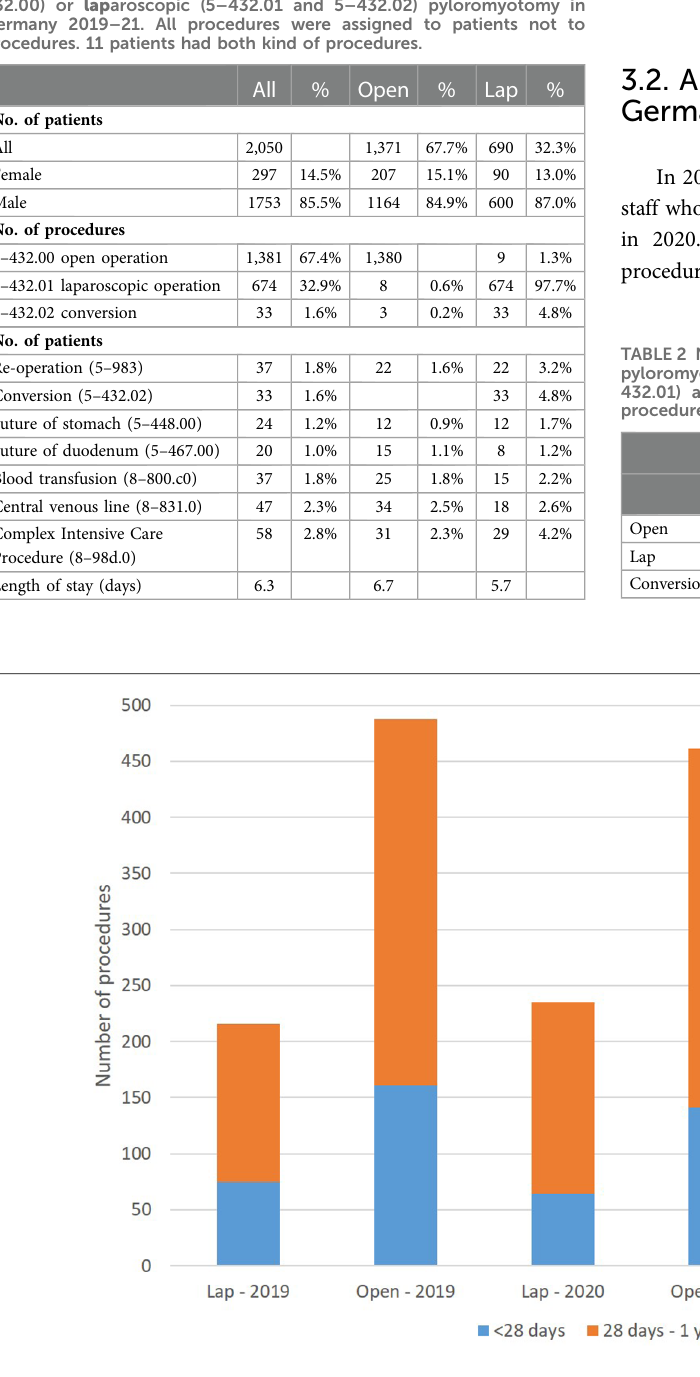
FIGURE 1 Number of patients undergoing laparoscopic or open pyloromyotomy (differences between age and surgical approach were not signi fi cant).